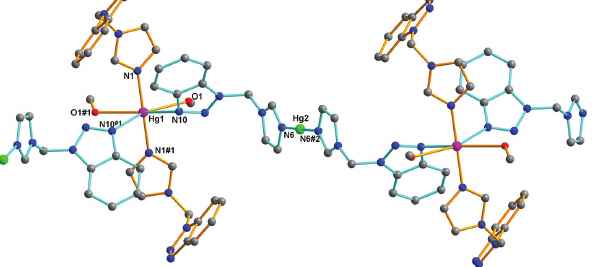
Table 1: Data collection and handling.